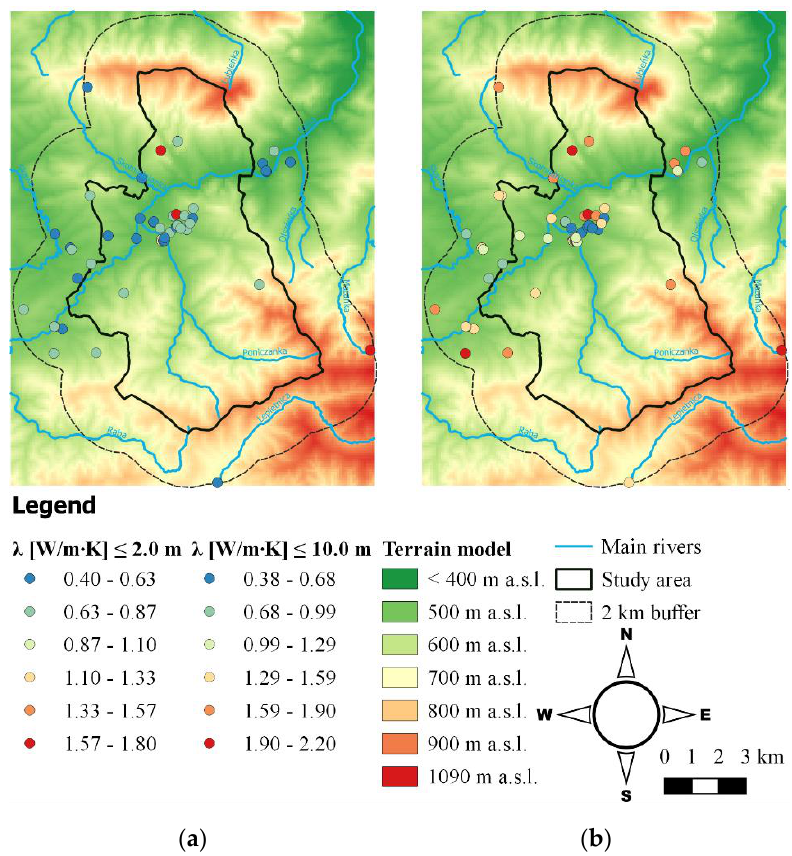
Figure 6. Estimated value of the thermal conductivity of the rock mass to a depth of: ( a ) 2 m; ( b ) 10